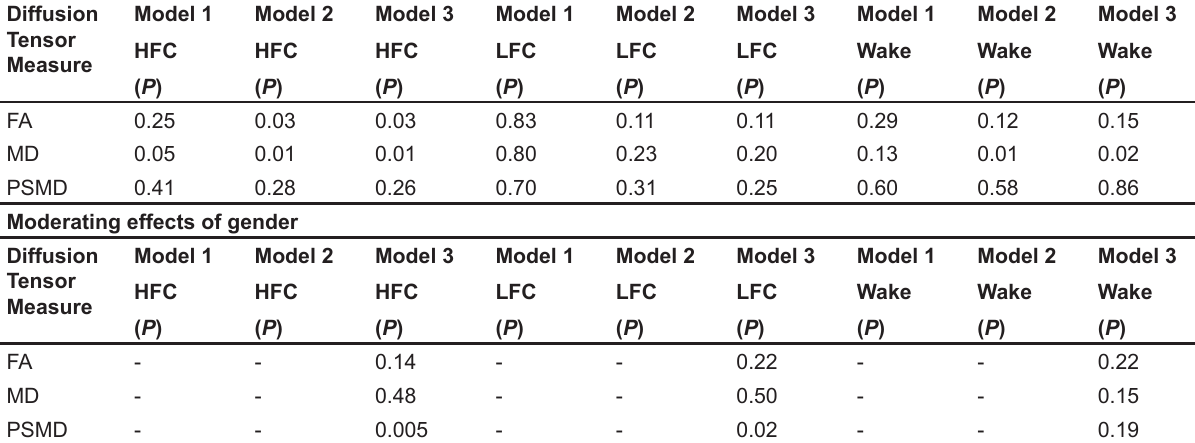
Table 4. Sleep quality and DTI